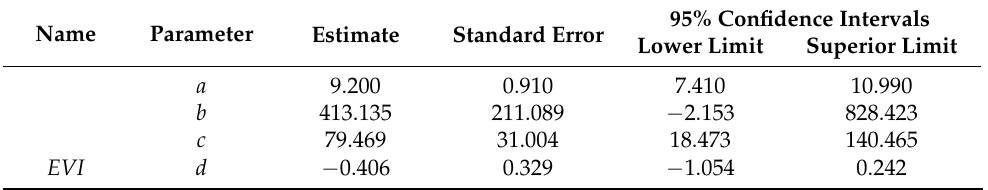
Table 2. Fitting results of the tropical rainforest biomass estimation remote sensing model (Model 3).